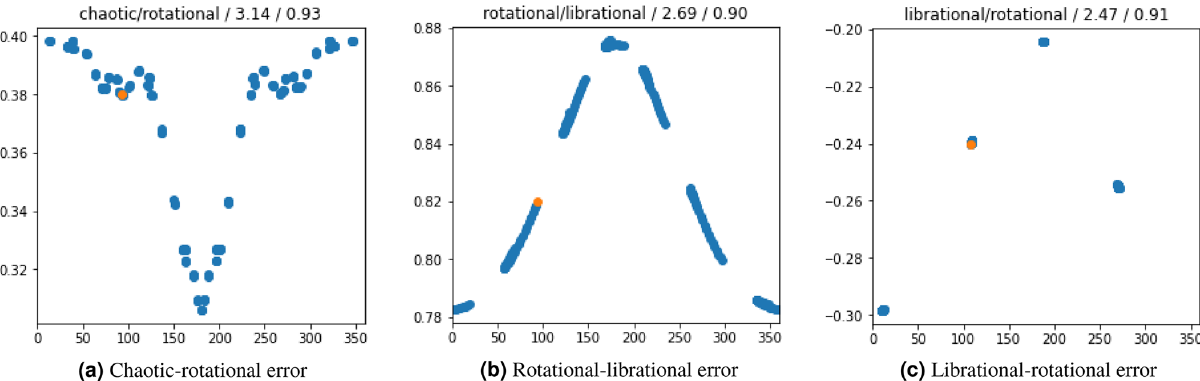
Figure 6. Motions with largest errors (values of the loss function) from the validation set of the first experiment, in which the network trained with data associated to the forced pendulum (1), with ε = 10 − 2 , 3 × 10 − 2 , and 5 × 10 − 2 , labelled using the FLI, and validated on a random subset of the training data. The initial point of the motion is marked in orange. Annotations on top of each image represent: DL prediction/FL index/ value of the loss function/probability of the predicted